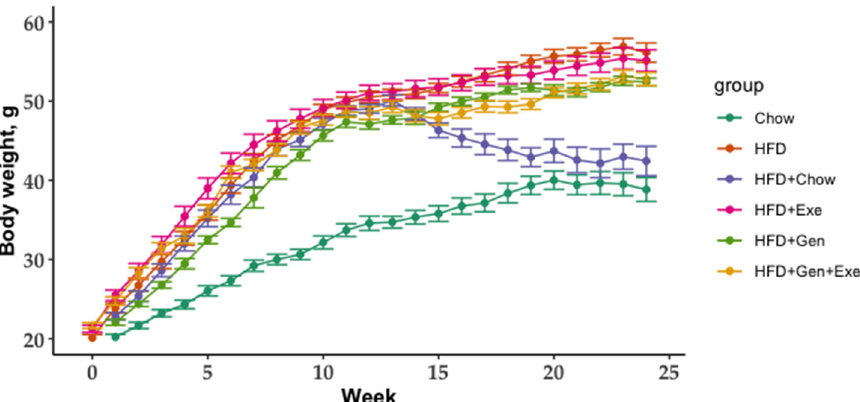
Figure 3. Body weight (g) over 24 weeks of six different dietary and exercise interventions using treatment groups are as follows: unpurified diet (chow); high-fat, high-sugar diet (HFD + chow); HFD; HFD + exercise (HFD + Exe); HFD + genistein (HFD + Gen); HFD + Exe + Gen.